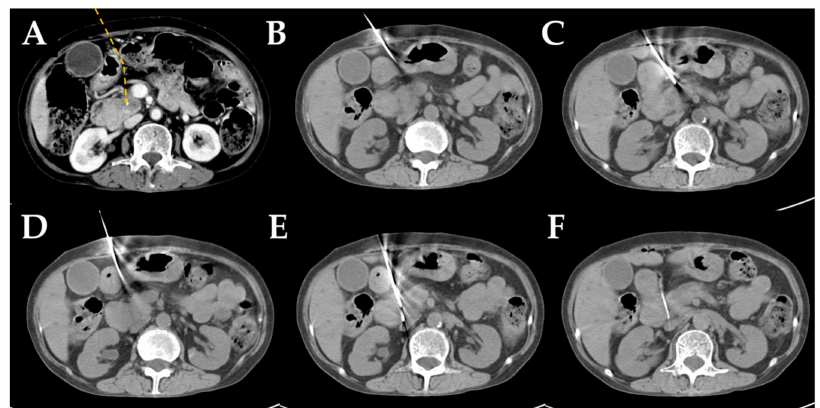
Figure A1. CT-guided core needle biopsy images via detour route 1.